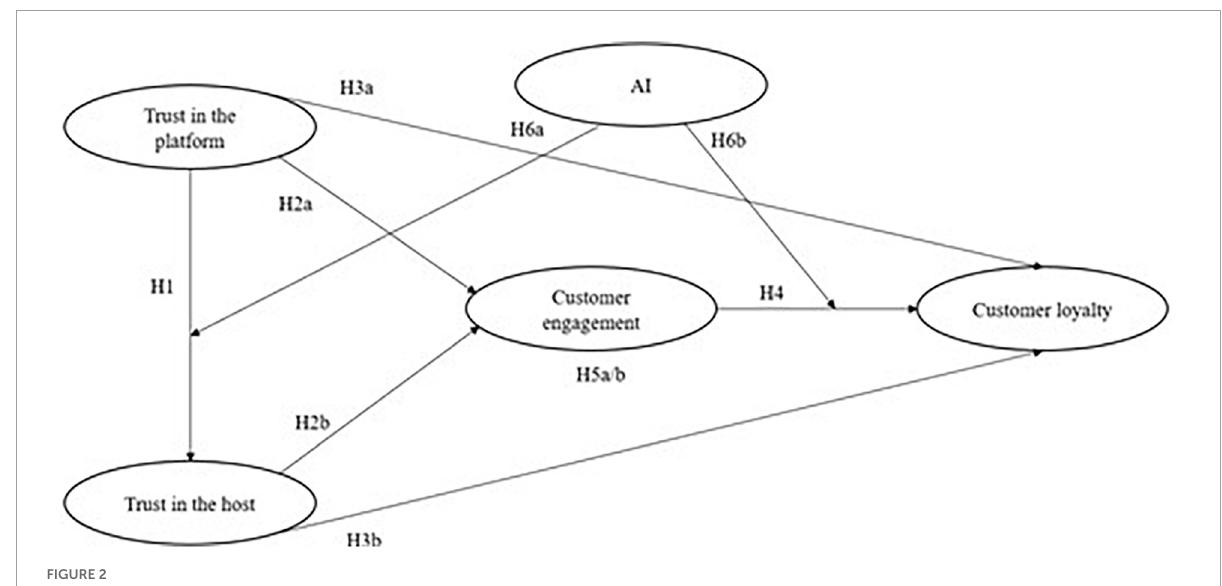
FIGURE2 The research